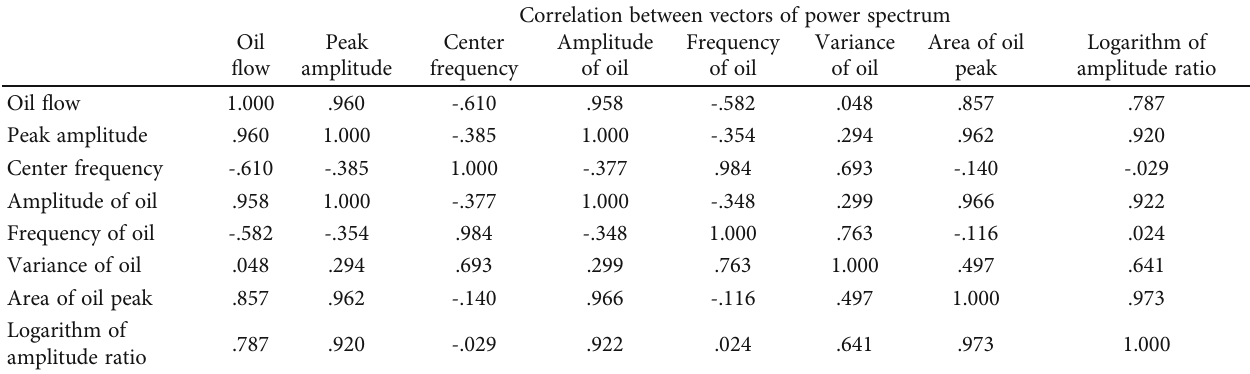
Table 1: Matrix table of approximate values of variables related to hydrostatic oil injection.